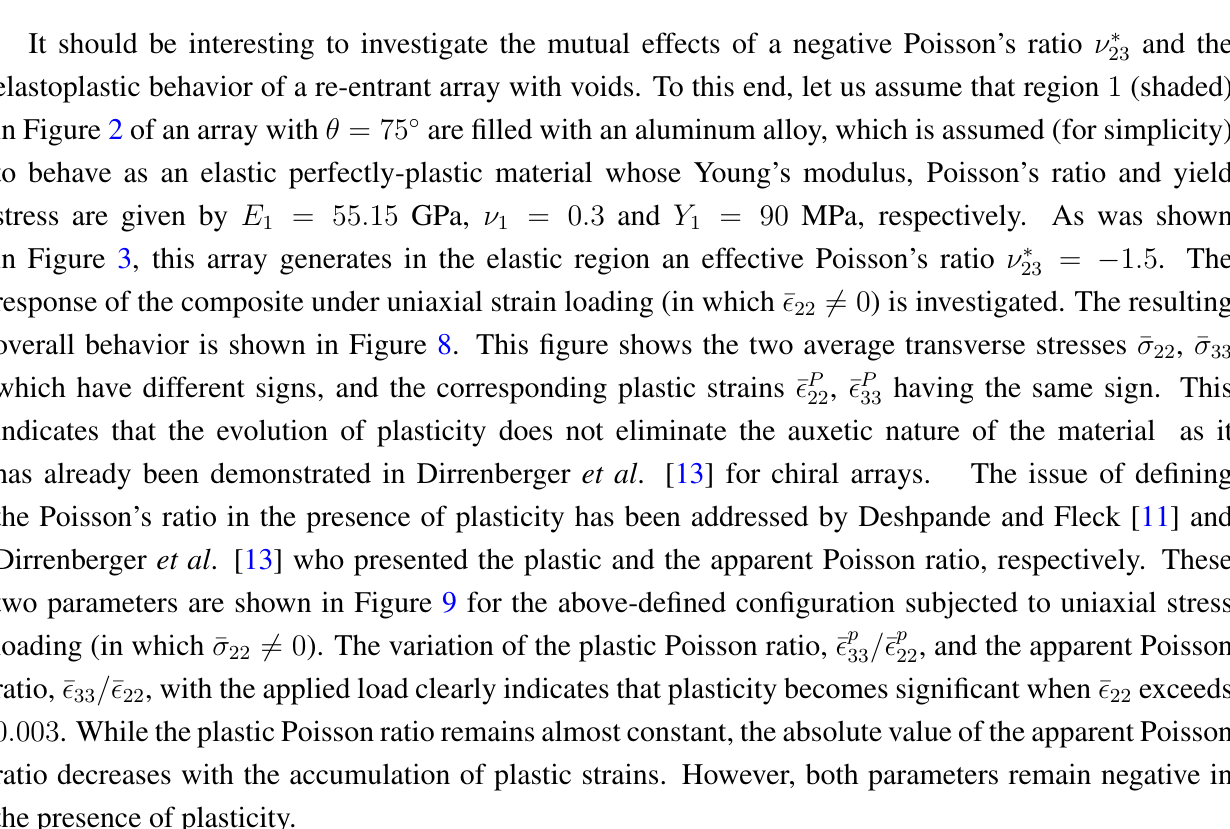
Figure 8. The elastoplastic response of aluminum with voids in the re-entrant array with θ = 75 ◦ that generates a negative effective elastic Poisson’s ratio. ( a ) Average transverse stresses and ( b ) transverse plastic